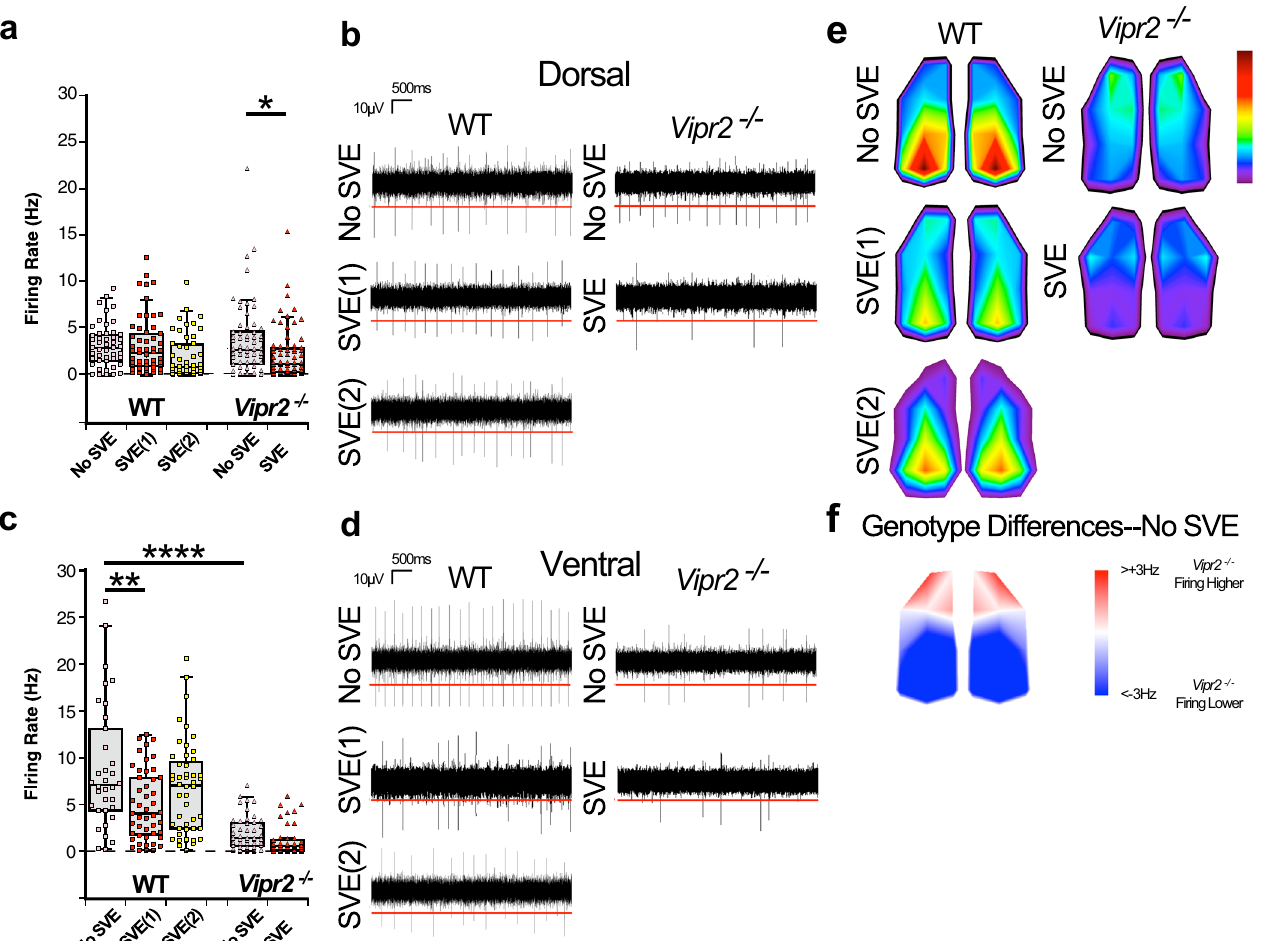
Fig. 4 Altered spontaneous action potential fi ring in the SCN of WT and neuropeptide signaling-de fi cient mice and its manipulation by SVE. Box plots overlaid with dot plots ( a , c ), example recordings ( b , d ), and topographical heatmaps ( e , f ) showing multiunit MEA recordings of spontaneous action potential fi ring at (~CT13 for non-SVE control mice, 1 h following onset of wheel availability/onset of activity for SVE Vipr2 − / − animals, and either 1 h following the onset of wheel availability (SVE(1)) or onset of behavior (drinking; SVE(2)) in WT mice). Also see Fig. S5. In the dorsal SCN subregion, fi ring